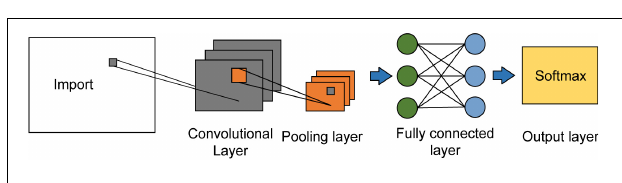
FIGURE 2 | The structure of